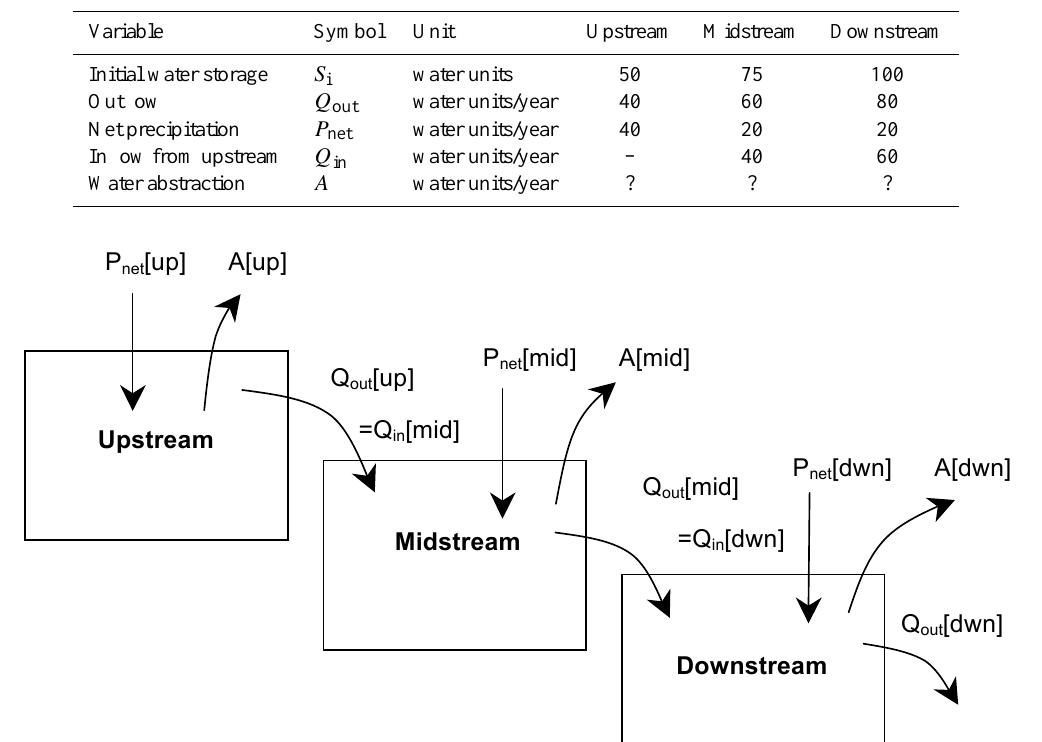
Fig. 2. Playing the Globalization of Water Role Play.